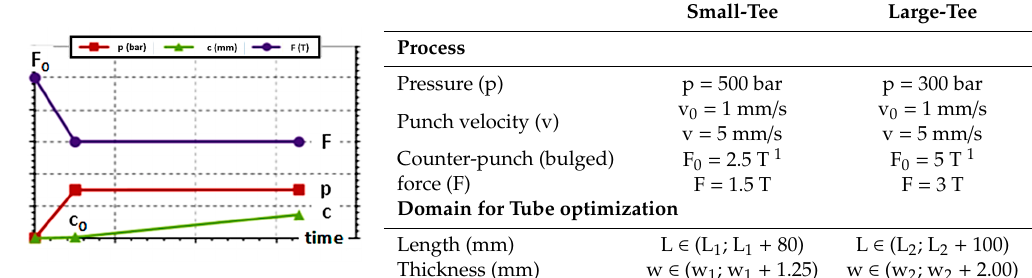
Table 2. Process parameter curves optimized and the FEM stability domain.